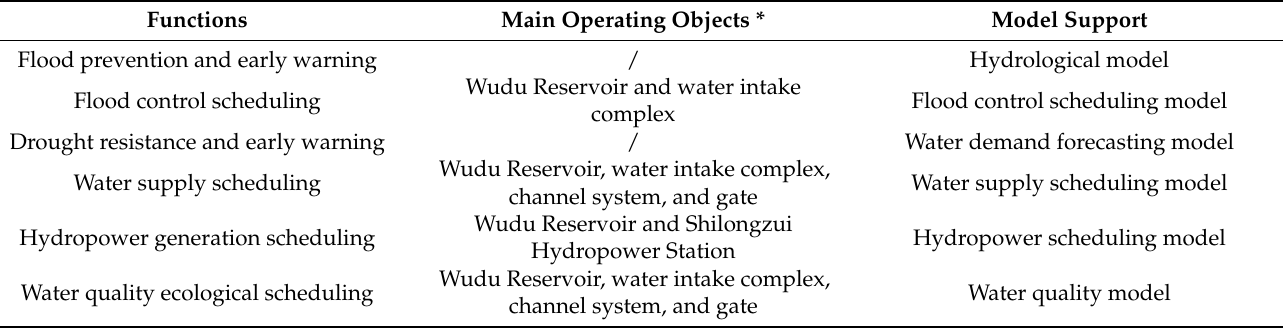
Table 1. Business functional requirements and model support table of the Wudu diversion and irrigation